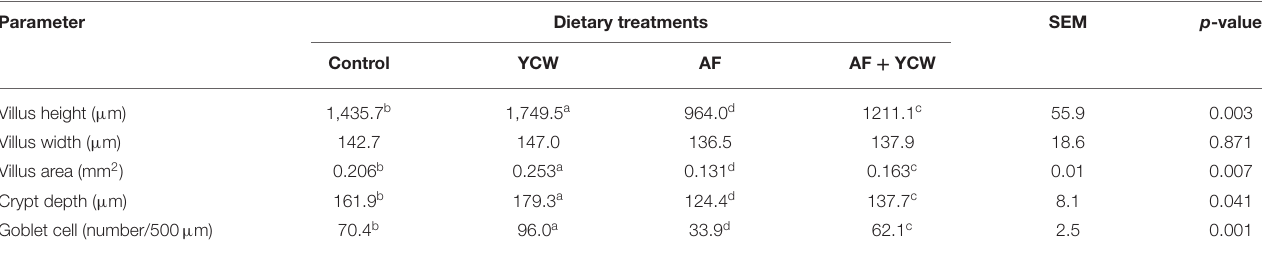
TABLE 5 | Histomorphological parameters of the broiler’s duodenum at 21 days of age. Parameter